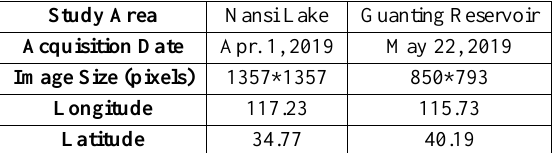
Table 1 Experiment images of AHSI onboard Gaofen-5 Satellite with water bodies.